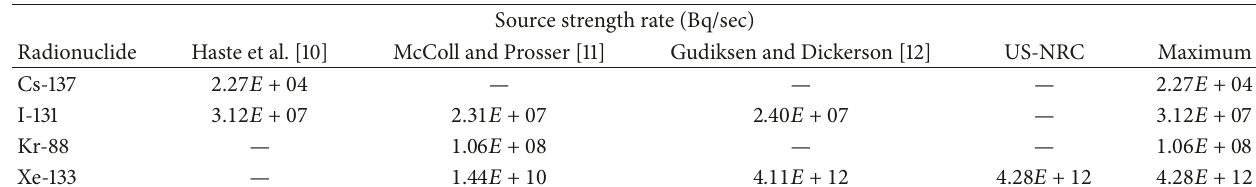
Table 3: Source term.